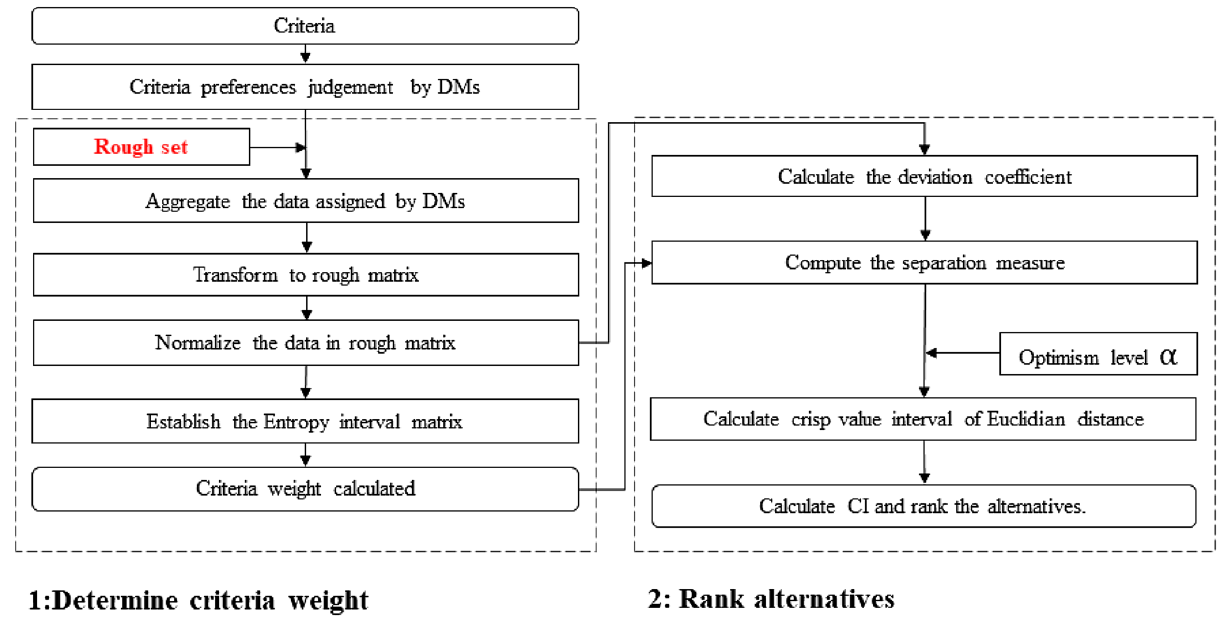
Figure 2. The process of the rough-TOPSIS